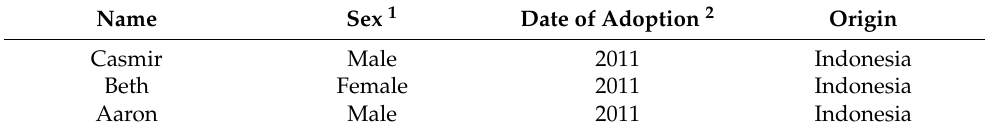
Table 1. Demographic information of the three Arapaima gigas at Ocean Park Hong Kong.